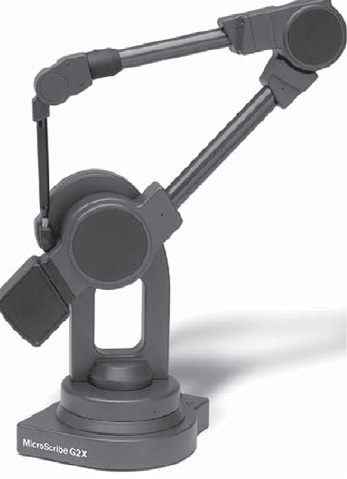
Fig. 8. The microscribe 3-dimensional coordinate measurement device.